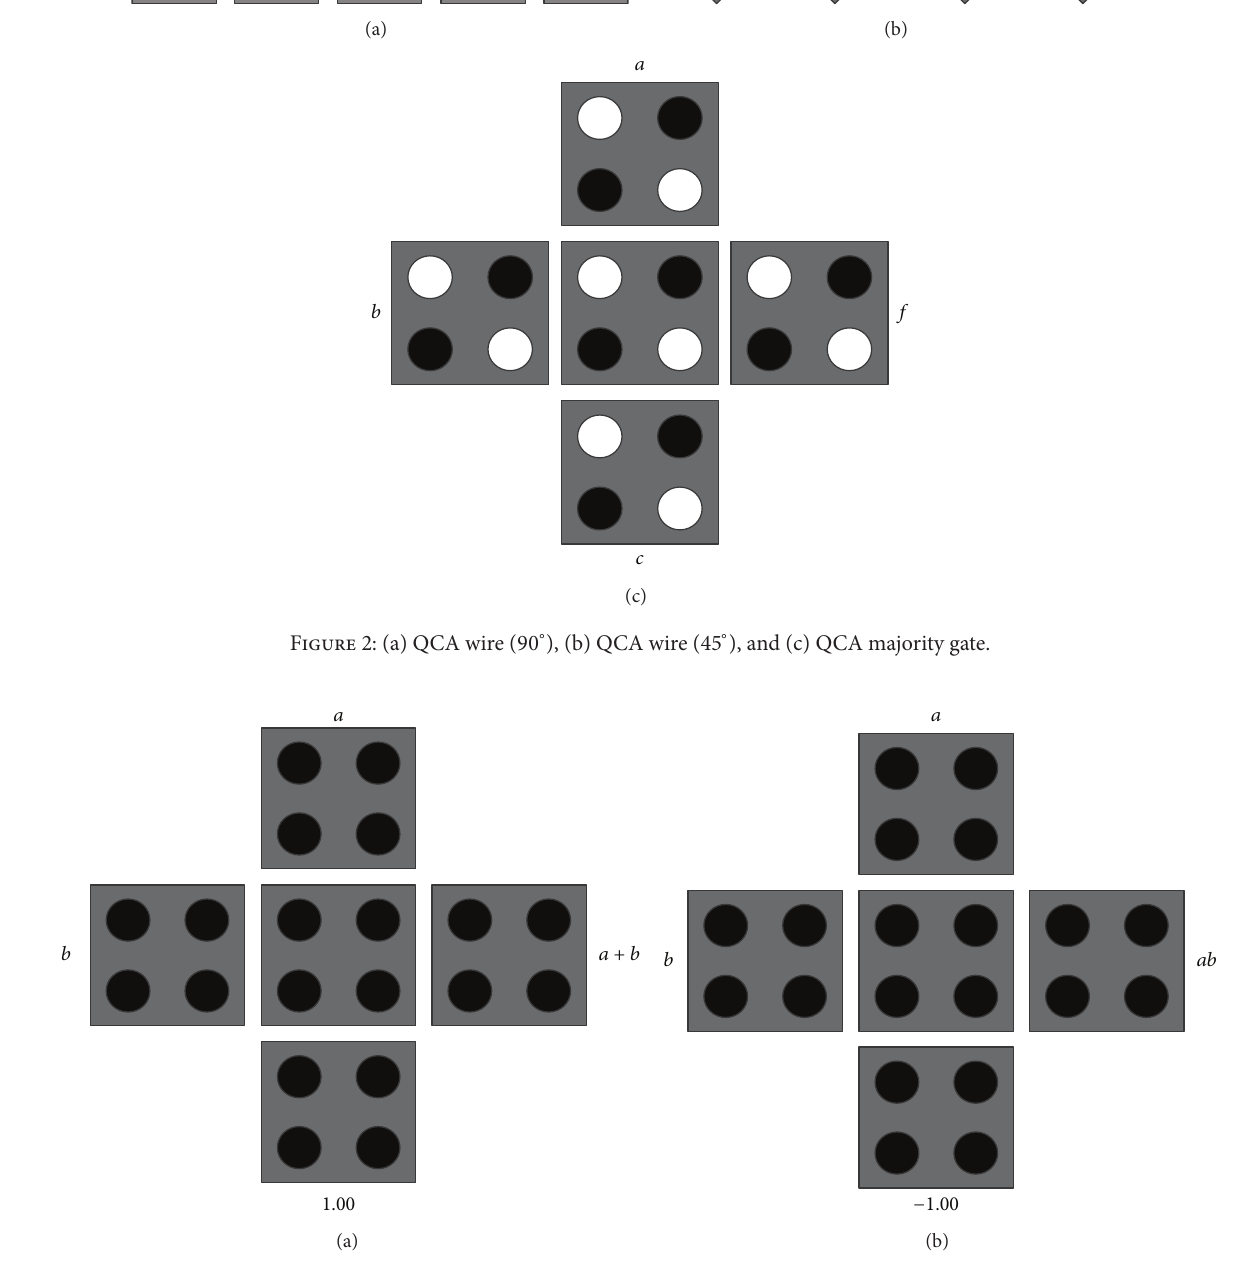
Figure 3: QCA layout of (a) OR gate and (b) AND